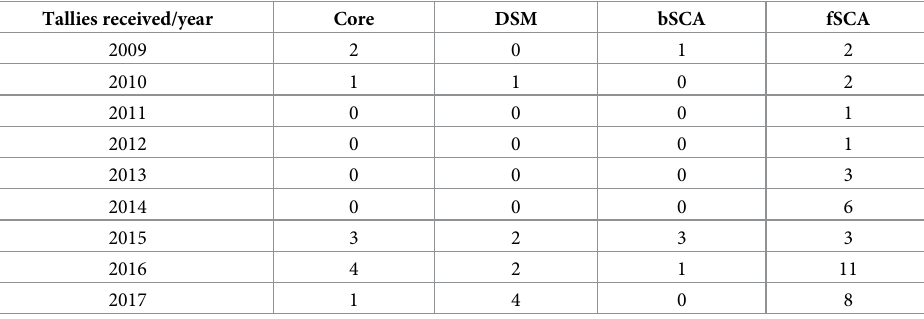
Table 3. A summary of the number of tallies received by each model per